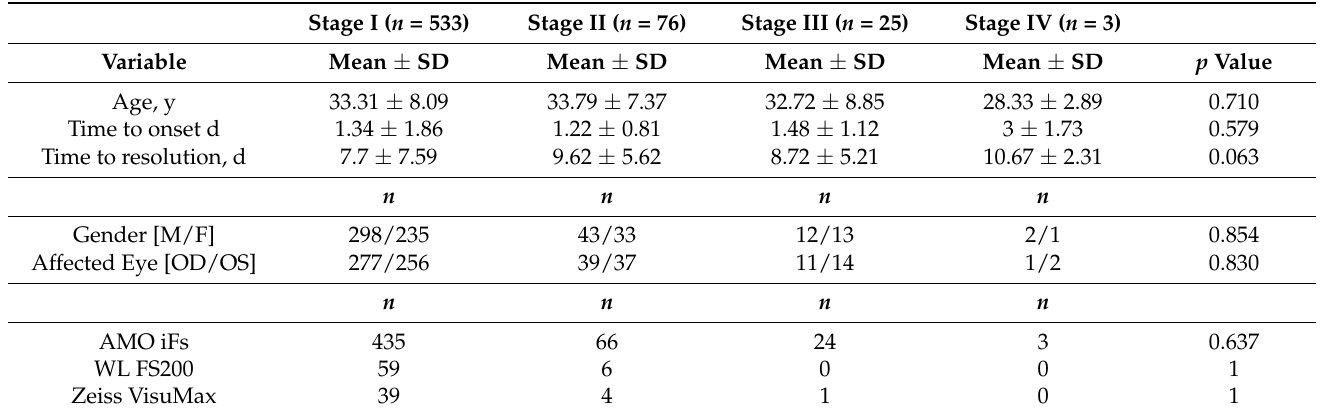
Table 3. Demographics comparison between different grades of DLK.